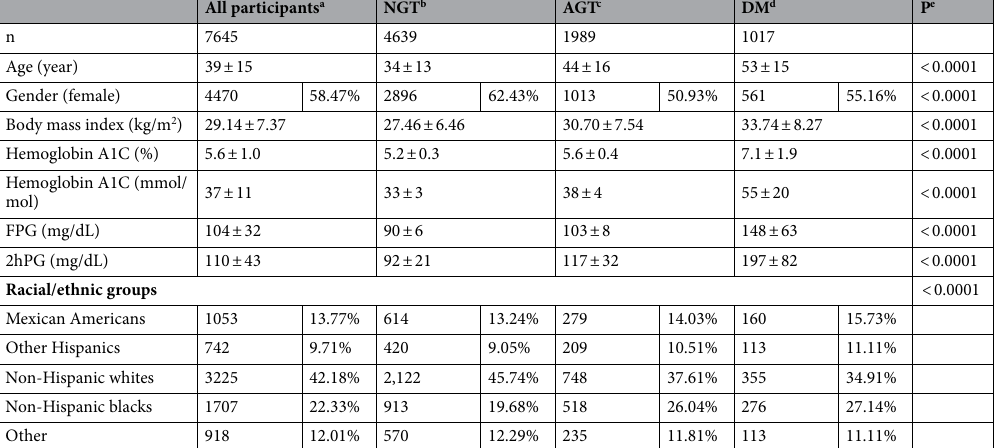
Table 1. The sample weighted prevalence of positive hepatitis B surface antigen (0.42%) and positive anti-hepati- tis B core antibody (4.85%) was consistent with the reported prevalence in the US population 9,10 . The impact of glucose tolerance state on seropositivity rate after hepatitis B vaccination. We compared hepatitis B seropositivity among vaccinated NGT, AGT, and DM groups (as defined in “Methods”). Sample-weighted analyses affected and increased seropositivity rates by 2–5% (Table 2). We observed a progres- sive decline of the seropositivity rate from the NGT group (53.64%) to the AGT group (45.52%) to the DM group (28.84%, P < 0.0001). Although the numeric changes were less impressive (8.12% in the AGT group and 24.80% in the DM group from the NGT group), this reflected a drastically proportional reduction: 15.15% reduction of seropositivity in the AGT group and a 46.25% reduction of seropositivity in the DM group when compared to that in the NGT group.